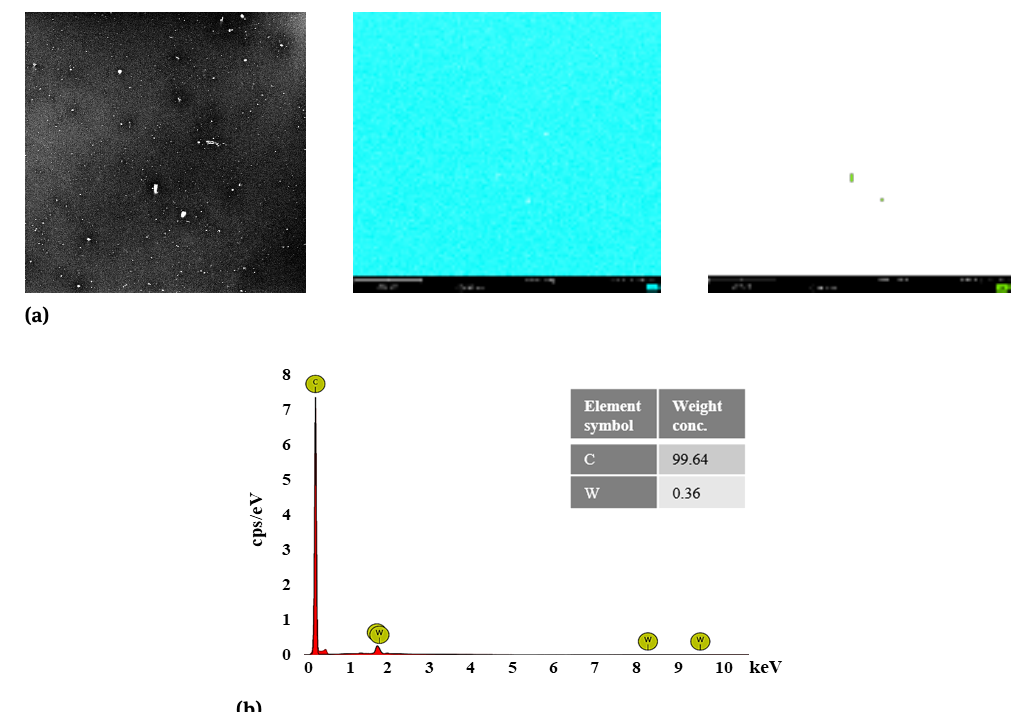
Figure 2: SEM images: a) view of the coating with a map of element concentration distribution, b) EDS spectrum with mass content of